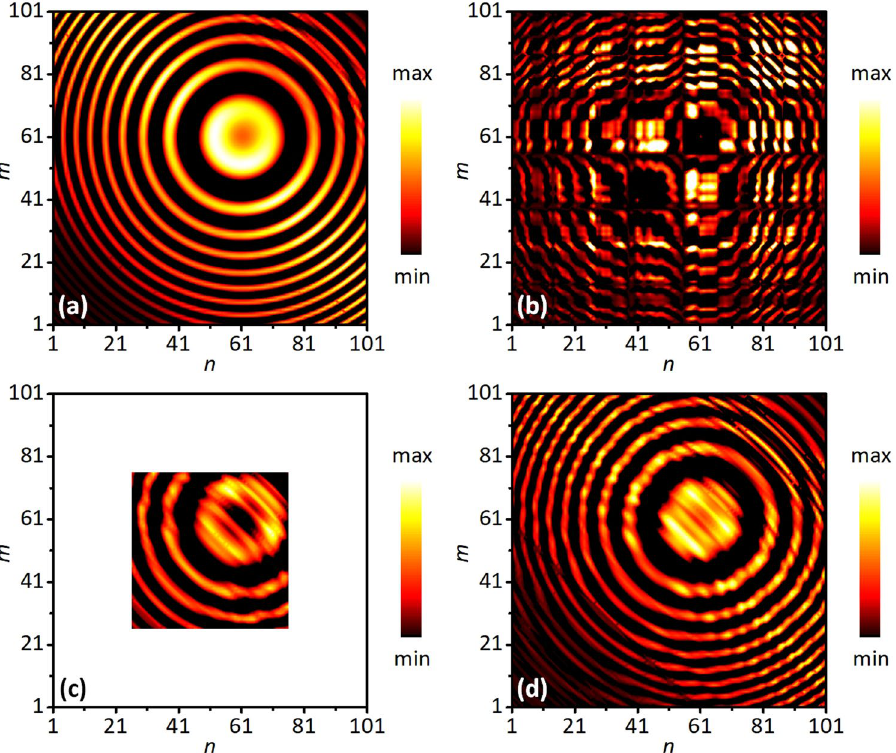
Figure 3. Results in a matrix formalism of the signals at time T = 58 μ s and frequency f = 2.0 MHz. ( a ) Real part of K without the scattering layer. ( b ) Real part of K with the scattering layer. ( c ) Real part of K F given by the filtered time reversal (FTR) method. ( d ) Real part of K F given by the correlation full-matrix filter (CFMF)